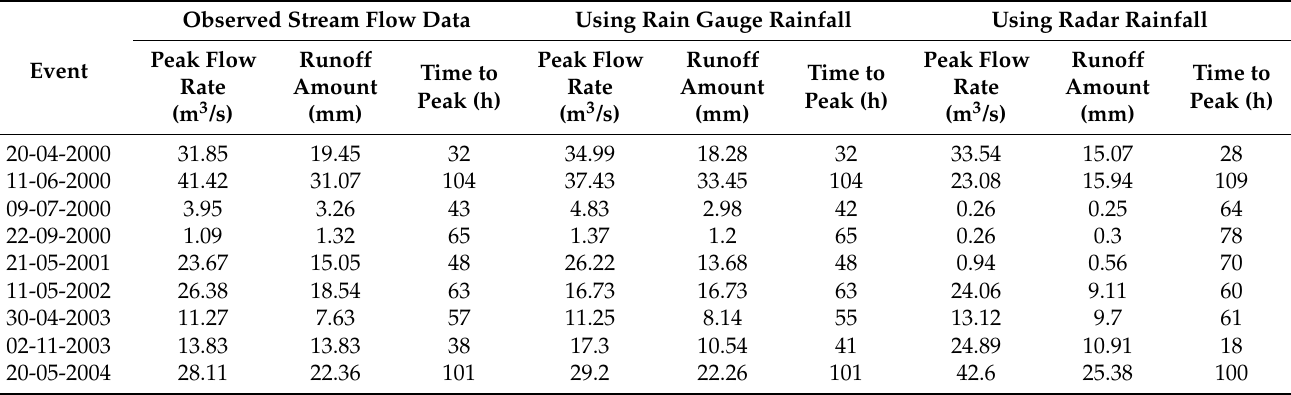
Table 4. Summary of observed and simulated peak flow rate, runoff amount, and time to peak obtained using calibrated SCS model parameters with rain gauge and radar rainfall inputs. Observed Stream Flow Data Using Rain Gauge Rainfall Using Radar Event